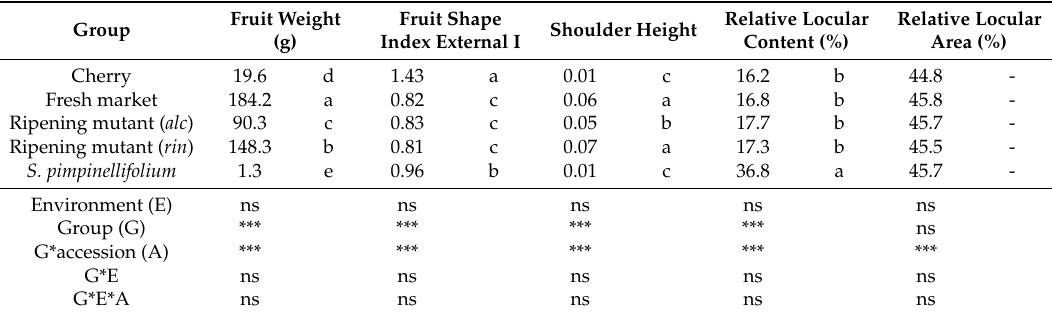
Table 3. Differences between tomato commercial groups for morphological traits. At the bottom, significance of the factors considered in the ANOVA (*** p < 0.001, ** p < 0.01, * p < 0.05, ns not significant). Within columns, different letters indicate significant differences (Student–Newman-Keuls